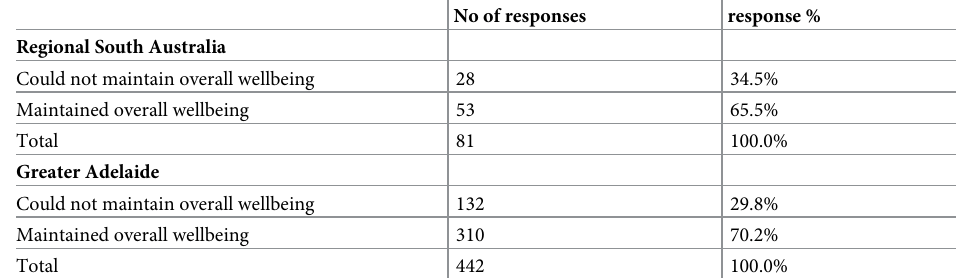
Table 2. Wellbeing in Regional and Greater Adelaide areas at time of survey. South Australia